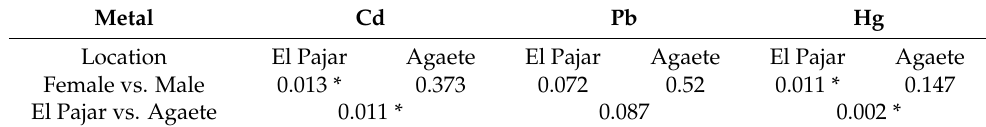
Table 4. PERMANOVA analysis of heavy metals in exoskeleton with the location and sex factors.